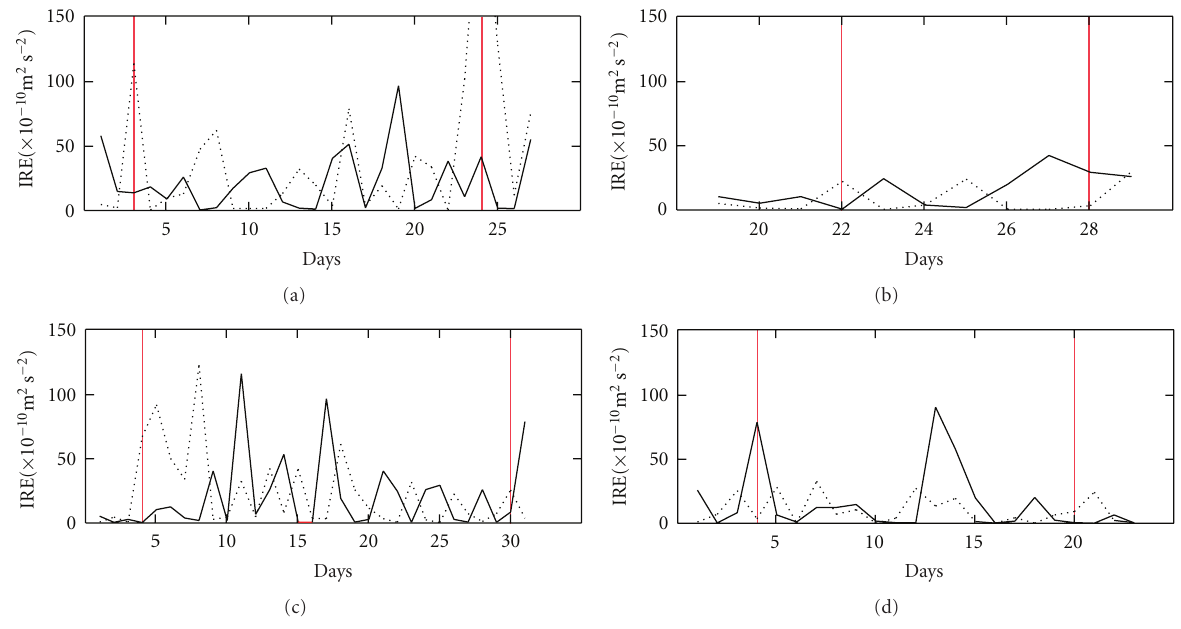
Figure 6: The IRE ( × 10 − 10 m 2 s − 2 ) for the (a) May, (b) June, (c) July, and (d) August 2010 blocking event where the solid line is the planetary- scale IRE (left ordinate) and the dotted line is the synoptic-scale IRE (right ordinate). The left (right) vertical line represents block onset (termination).